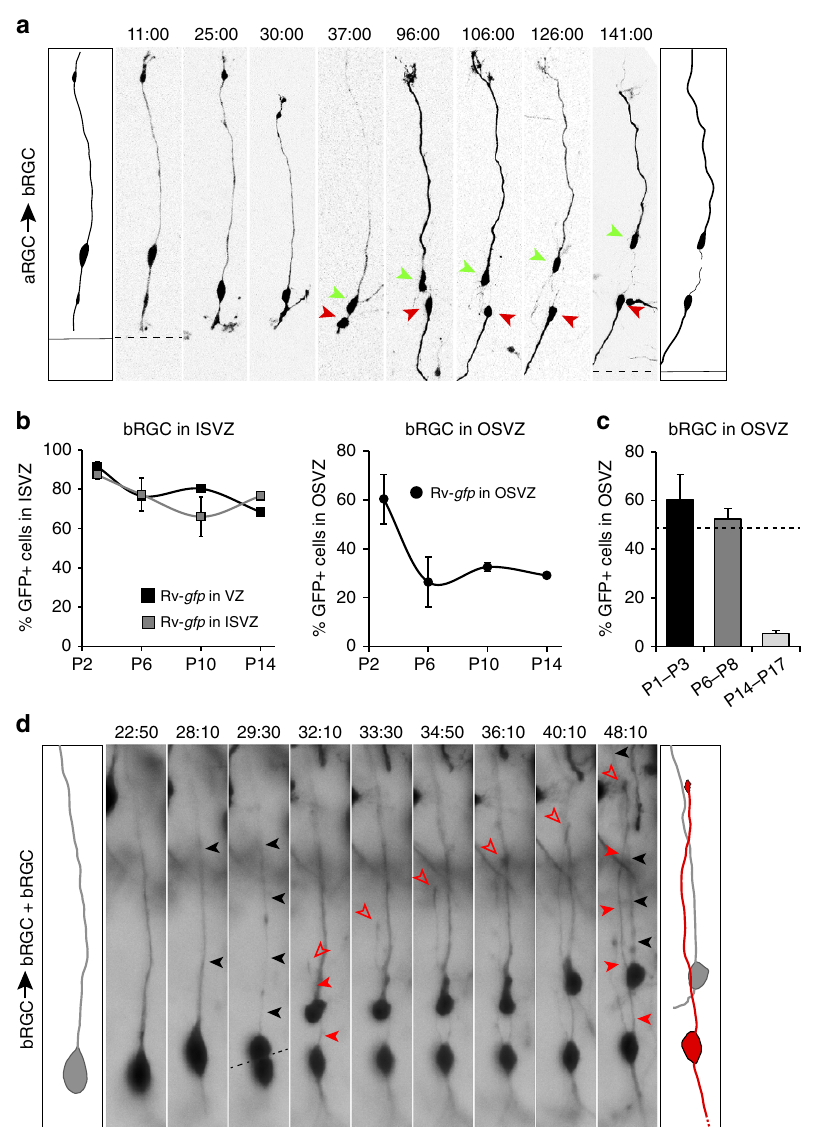
Figure 2 | Postnatal aRGCs generate ISVZ bRGCs, while OSVZ bRGCs are generated by self-amplification. ( a ) Time-lapse imaging frames of an aRGC dividing apically, between 30 and 37h of imaging time, to generate a bRGC (green arrowhead) retaining the basal process. The apical cell (red arrowhead) retained the apical process. ( b ) Abundance of GFP þ bRGCs located in ISVZ after VZ and ISVZ infections at P1 or in OSVZ after OSVZ injections at P1, and analysed at the indicated ages (mean values þ s.e.m.; n ¼ 420–5,544 cells, 2–5 animals per group; Supplementary Table 1). ( c ) Abundance of GFP þ bRGCs in OSVZ at the indicated postnatal stages after injections of rv:: Gfp in OSVZ and 2–3 days of survival. Data are mean ± s.e.m. ( n ¼ 420 cells, 3 animals, P1– P3; 1,288 cells, 4 animals, P6–P8; 819 cells, 2 animals, P14–P17); dashed line indicates 50%. ( d ) Time-lapse imaging frames of a bRGC in OSVZ with a basal process (black arrowheads), undergoing a near-horizontal division at t ¼ 29:30 hours (dashed line) to generate two bRGCs. The basal daughter cell (top) retained the maternal basal process, whereas the apical daughter (bottom) grew a new basal process (solid red arrowheads) tipped with a small growth cone (red open